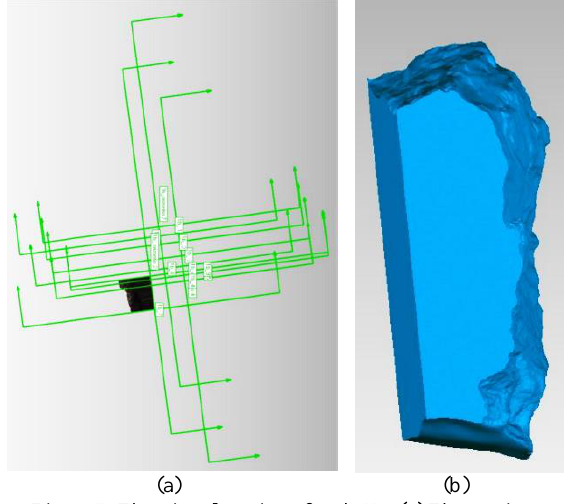
Figure 7: The virtual cutting of rock 1B. (a) The cutting planes, (b) An example of a rock segment.